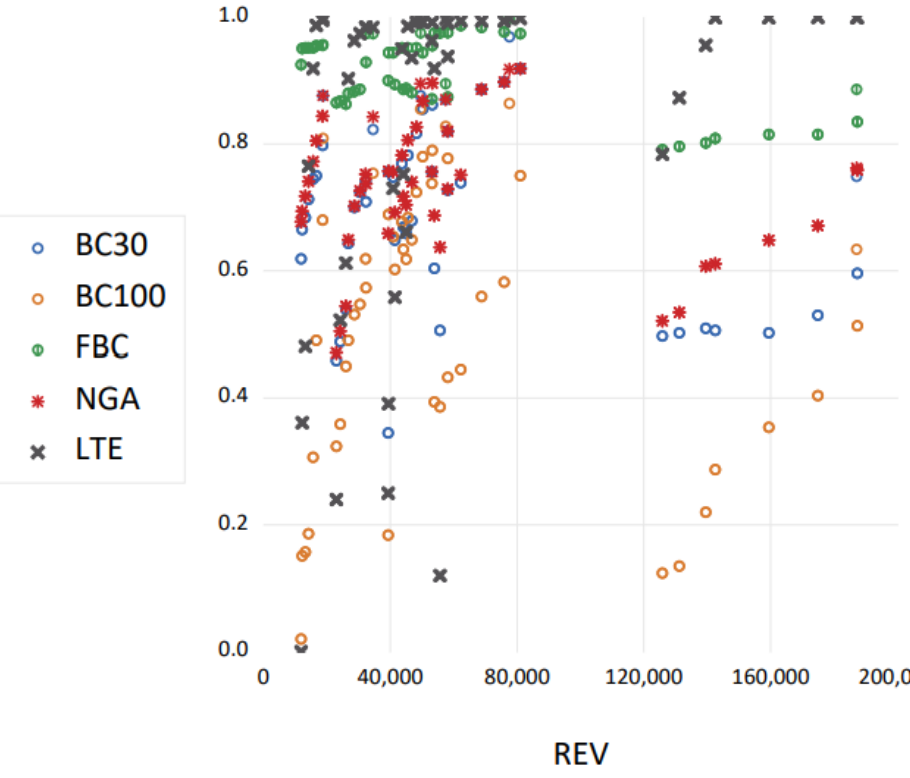
Figure 3. Broadband networks coverage and the total receipts from taxes and social contributions .